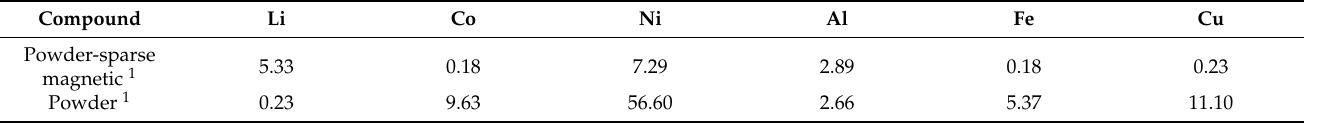
Table 7. ICP-OES analysis of relevant elements in the produced powder fraction after the InduMelt experiment in wt.-%.